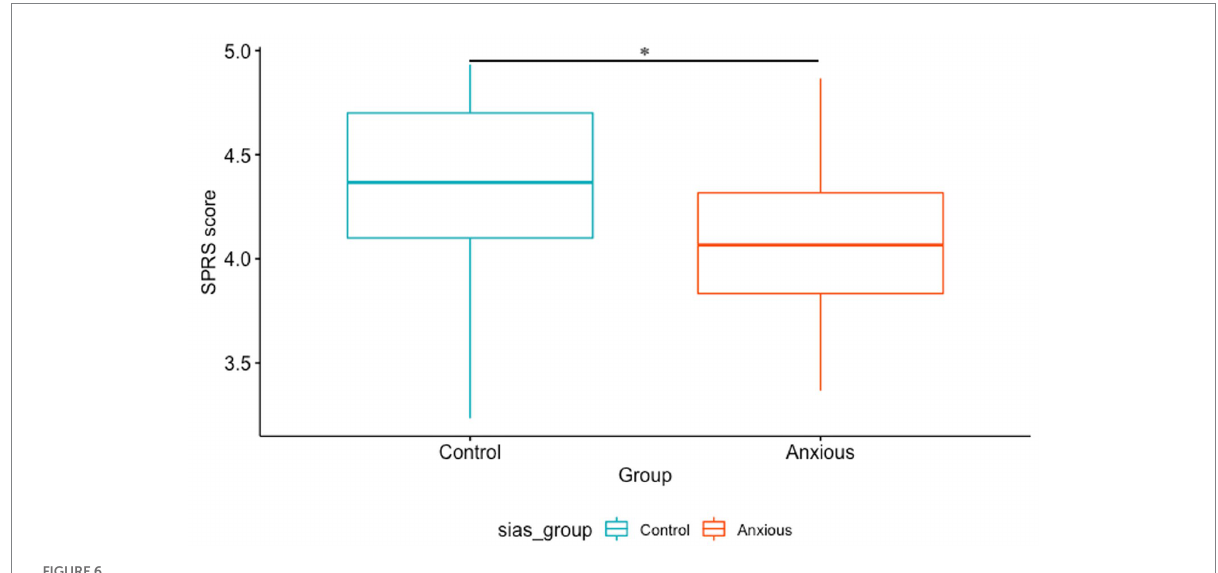
FIGURE 6 SPRS score according to group (anxious vs. control) * p <